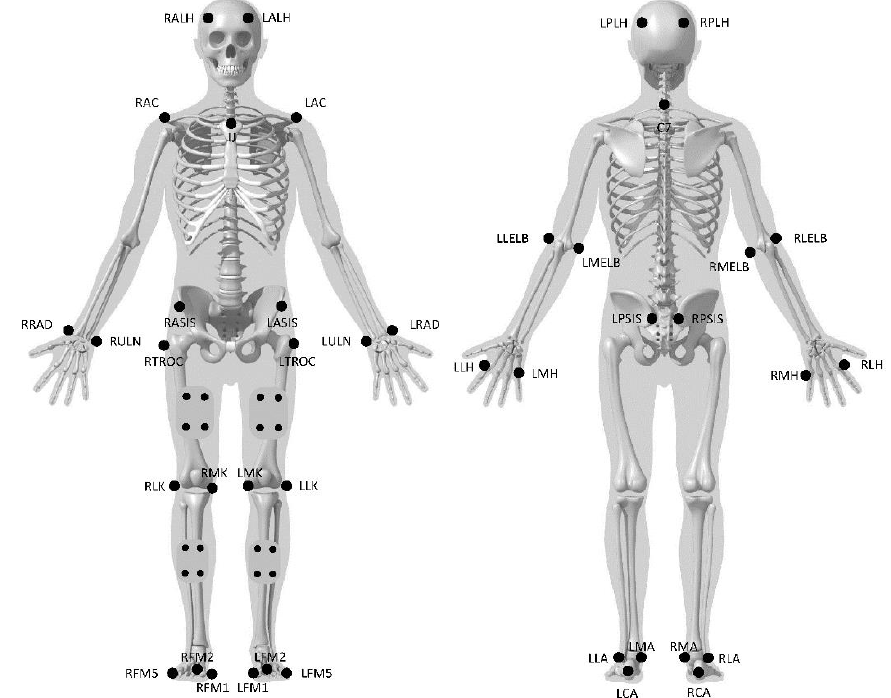
Figure 5. Anatomical position of the retroreflective markers. RALH/LALH: right/left anterior left head; RPLH/LPLH: right/left posterior lateral head; RAC/LAC: right/left acromion; C7: seventh cervical vertebra; IJ: incisura jugularis; RLELB/LLELB: right/left lateral elbow; RMELB/LMELB: right/left medial elbow; RRAD/LRAD: right/left radium; RULN, LULN: right/left ulna; RLH/LLH: right/left lateral hand; RMH/LMH: right/left medial hand; RASIS/LASIS: right/left ante- rior superior iliac crest; RPSIS, LPSIS: right/left posterior superior iliac spine; RTROC/LTROC: right/left great trochanter; RLK/LLK: right/left lateral knee; RMK/LMK: right/left medial knee; RLA/LLA: right/left lateral ankle; RMA/LMA: right/left medial ankle; RCA/LCA: right/left calcaneus; RFM1/LFM1: right/left first metatarsal bone; RFM2/LFM2: right/left second metatarsal bone; RFM5/LFM5: right/left fifth metatarsal bone.